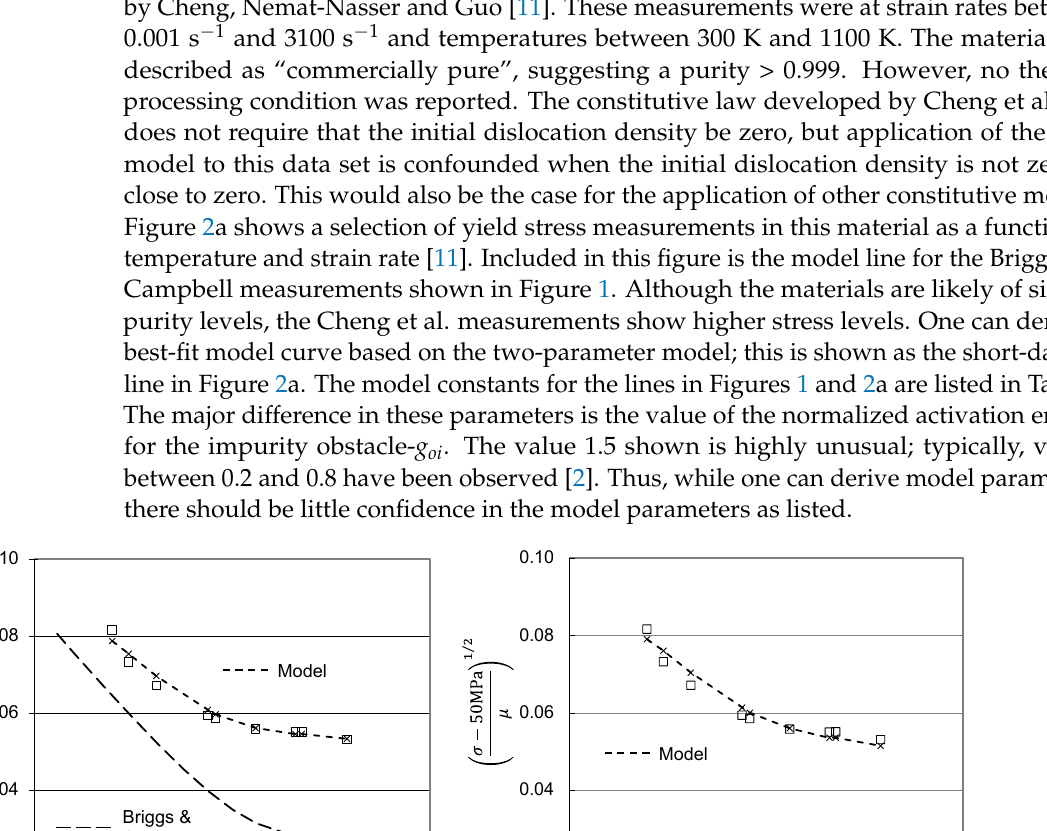
Figure 1. Briggs and Campbell measurements [9] in pure molybdenum analyzed according to Equa- tions (2) and (3).